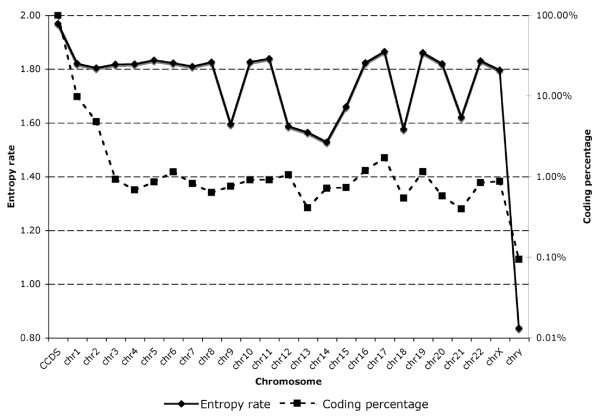
The entropy, or information content (solid line, left Y axis) and percent of the sequence coding for proteins (dashed line, right Y axis, log scale) for each human chromosome as well as the full set of coding regions (CCDS). Given the higher entropy rate of coding regions to non-coding regions, we expect a correlation between the two measurements. However, chromosomes 1, 2, 9, 12, and 14 have a lower information content than might be expected for the percent of those chromosomes occupied by protein coding regions. Chromosome 20 appears to have a higher entropy than would be expected given its gene poor content. This may be a signal of extensive non-protein coding, yet functional RNA on chromosome 20.